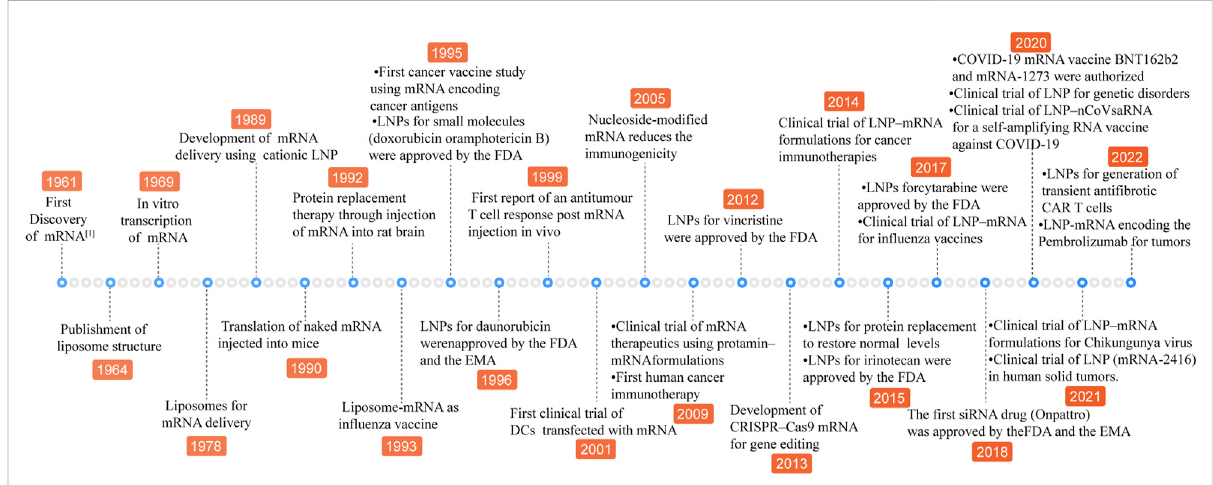
FIGURE 1 Hallmarks of mRNA-lipid nanoparticles. LNP, lipid nanoparticle; COVID-19, coronavirus disease 2019; CRISPR/Cas9, Clustered Regularly Interspaced Short Palindromic Repeats/CRISPR-associated protein